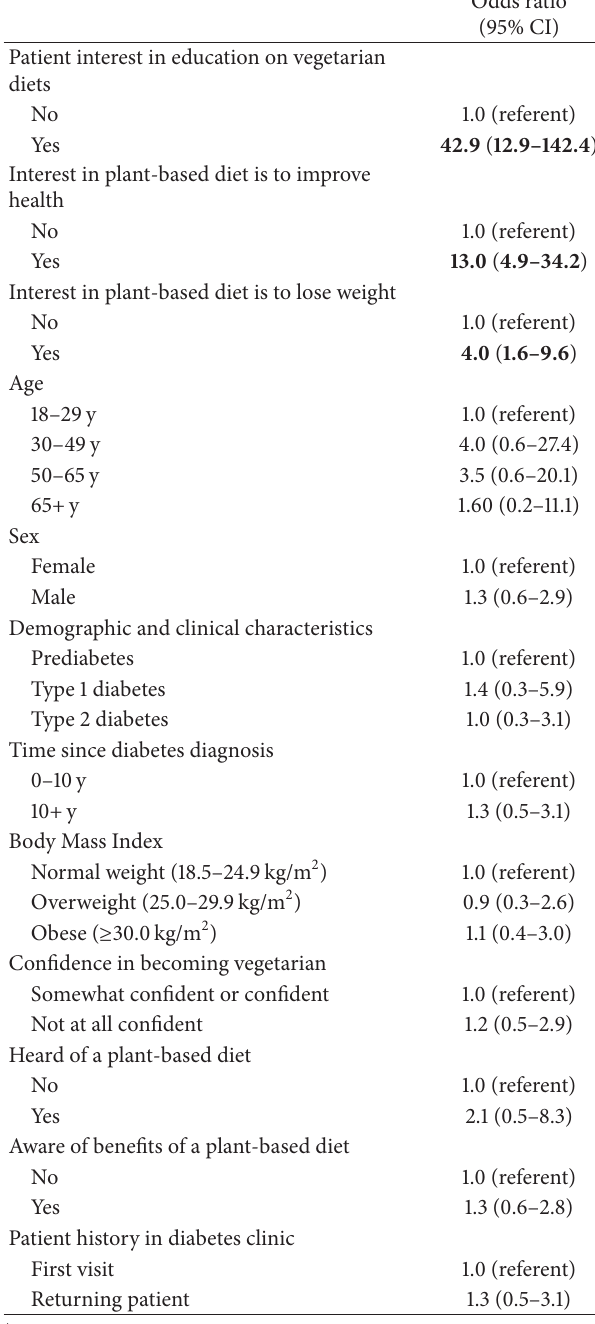
Table 2: Unadjusted logistic regression between clinical and patient-education factors on willingness to change to a vegetarian diet ∗